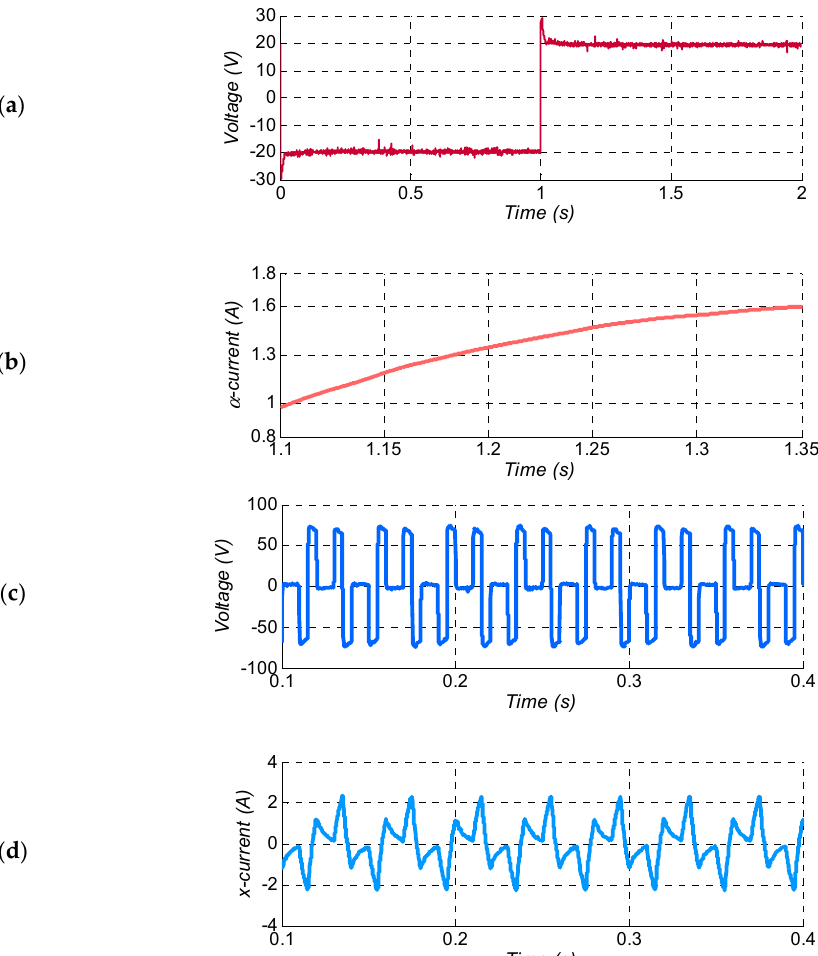
Figure 4. Applied stator voltage in the winding connection 1 ( a ) and the measured i s α ( b ). Applied stator voltage in the winding connection 2 ( c ) and the measured i sx ( d ).